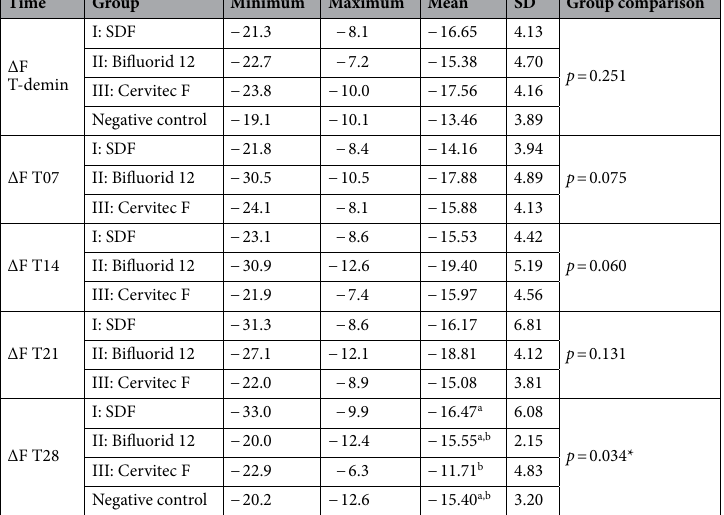
Table 1. Results of the QLF measurements in different groups: ΔF (fluorescence loss [%]) shows avarage fluorescence loss in a lesion and is related to the loss of mineral content and to lesion depth (SD: standard deviation). *Different superscript letters indicate significant differences between the